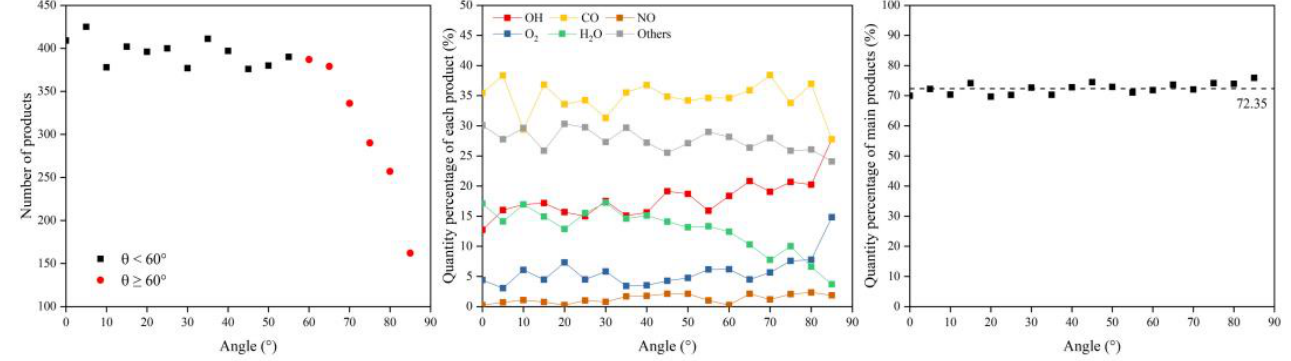
Figure 14. Product information of the Kapton after atomic oxygen impact at different incidence angles.